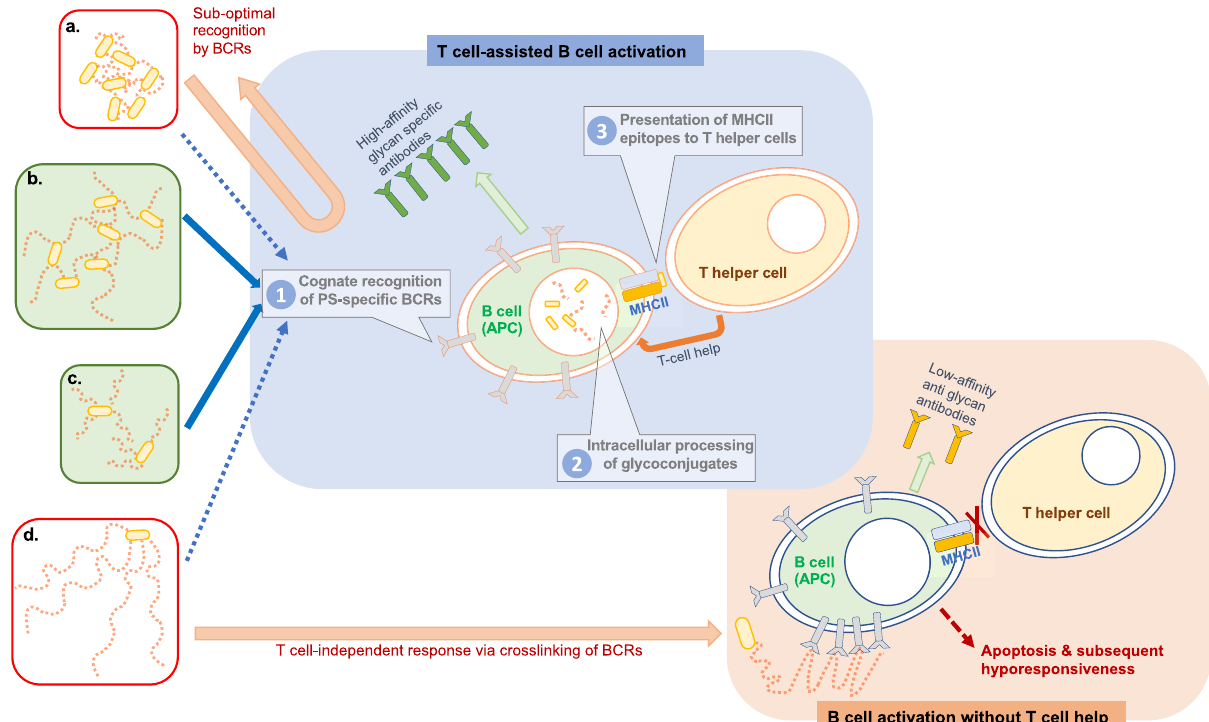
Fig. 4 A hypothetical model of the role of chain length in the interaction of glycoconjugates with antigen-presenting B cells (APC) and T helper cells. The necessary steps for glycoconjugate vaccines to engender B cell maturation and production of glycan-speci fi c antibodies are enumerated in the central blue segment. Glycoconjugate construct ( a ) contains medium-sized glycan chains that are excessively cross-linked and therefore not suf fi ciently accessible to be optimally recognized by the B cell receptors (BCRs). Instead, functional vaccines can be achieved by rational design of linkage sites and chain lengths in the vaccine molecule. Appropriate levels of cross-linking of long-chain polysaccharides (construct b ) or end-linked chemistries for medium-sized oligosaccharides (construct c ) can lead to protective glycoconjugate vaccines. In those settings, T-helper cells recognize the MHCII-bound peptide complexes and become activated. With T-helper cell support, cognate B cells mature to memory B cells and produce glycan-speci fi c antibodies. However, excessively long glycan stretches (construct d ) may act similar to unconjugated PS and cross-link BCRs, generating mainly T cell-independent immune responses resulting in hyporesponsiveness. Without T-helper cell support, B cells become temporarily activated but proceed to undergo apoptosis, impeding the production of long-lasting memory B cells and long-lived plasma cells 81